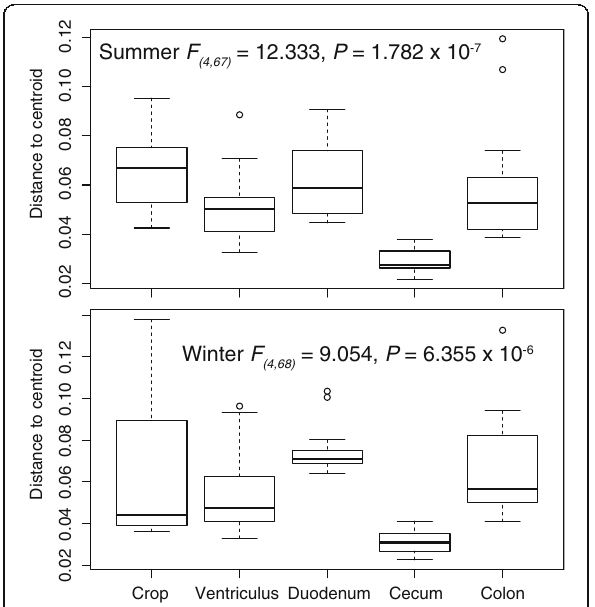
Fig. 5 Differences in β -diversity dispersion (average distance to median) among gut regions in summer (top) and winter (bottom). Results of Tukey ’ s multiple comparison tests are presented in Additional file